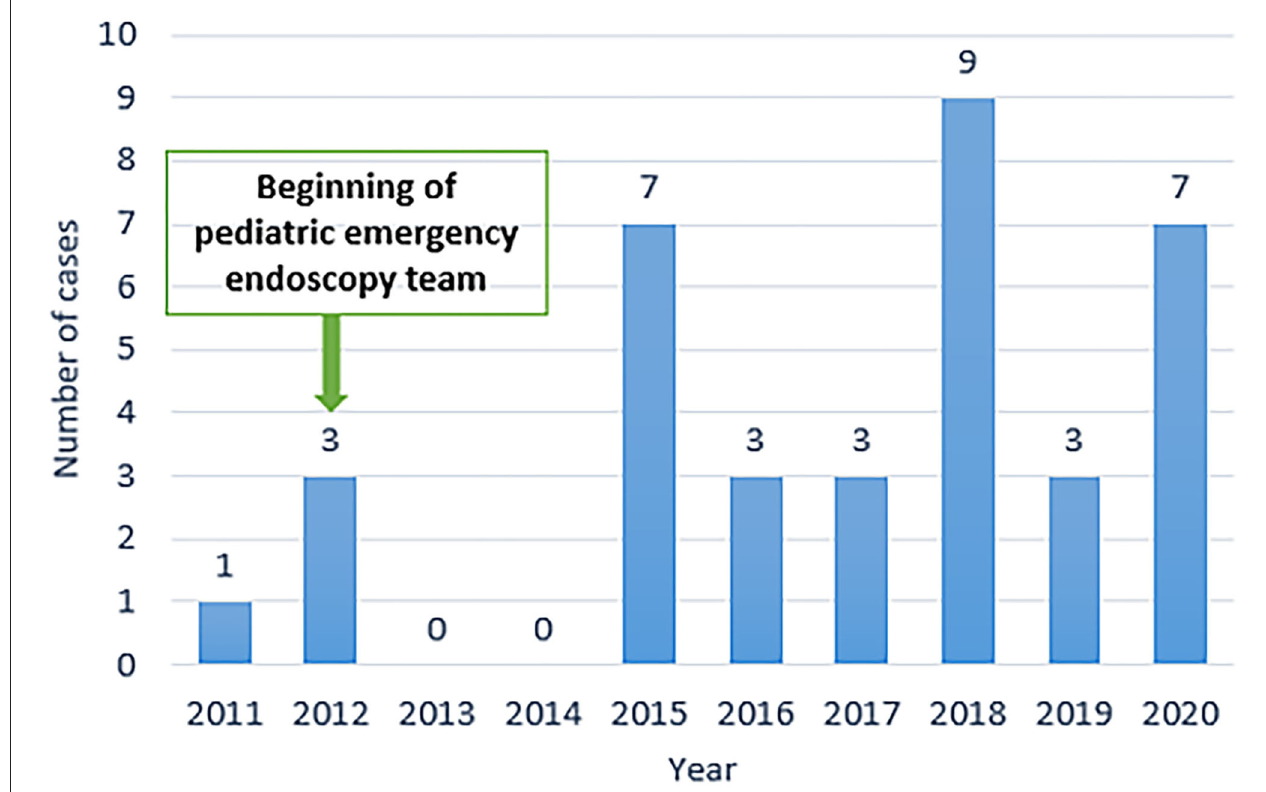
FIGURE 1 | Number of battery ingestion episodes per